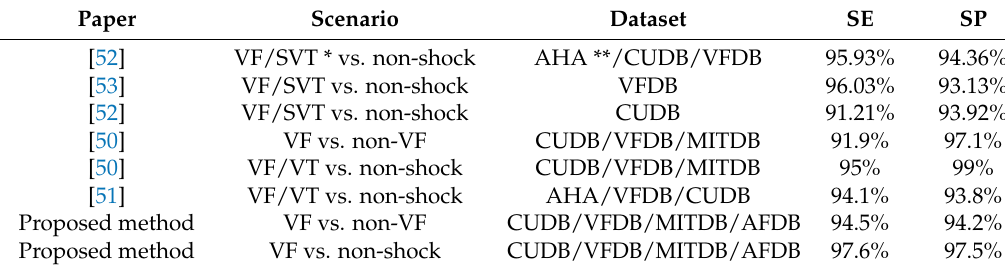
Table 11. Performance of published methods which focus on VF and VT detection vs. our proposed method.